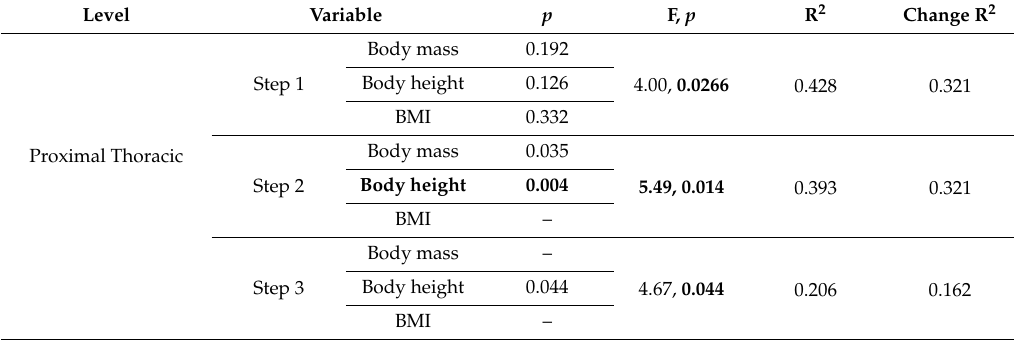
Table 4. The regression analysis predicting the mean of ATR value in girls aged 13 years ( n = 307).